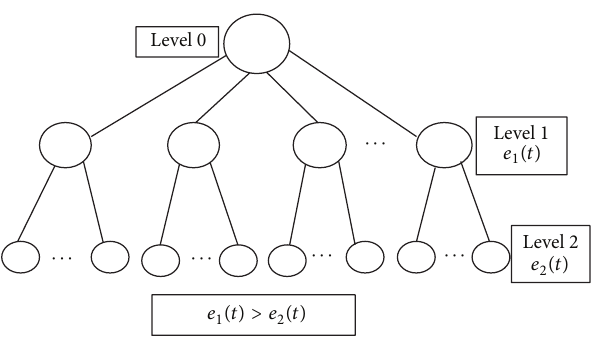
Figure 1: Hierarchical energy